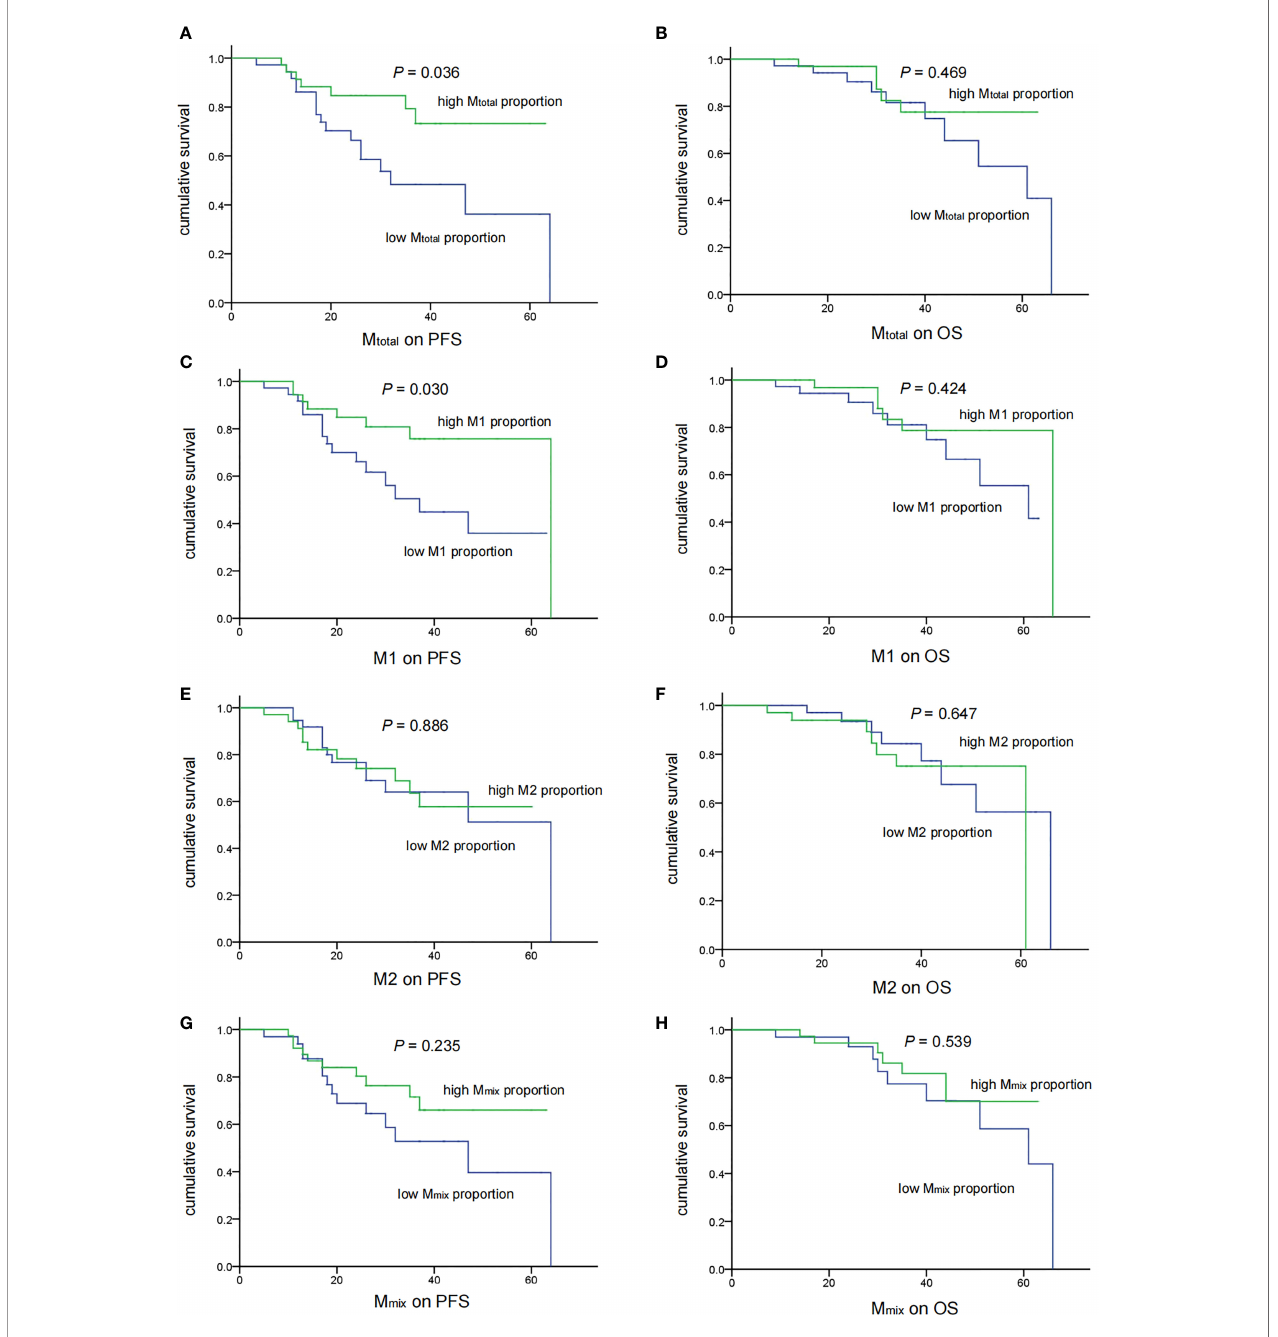
FIGURE 3 | Associations of TAM recruitment with treatment outcomes in medulloblastoma patients (n = 71). There were signi fi cant correlations of low M total (A) ( P = 0.036) and M1 (C) ( P = 0.030) recruitment with shorter PFS. No signi fi cant correlation of M total (B) and M1 (D) with OS was observed ( P = 0.469 and 0.424 respectively). M2 and M mix recruitment showed no correlation with the PFS and OS (E – H)